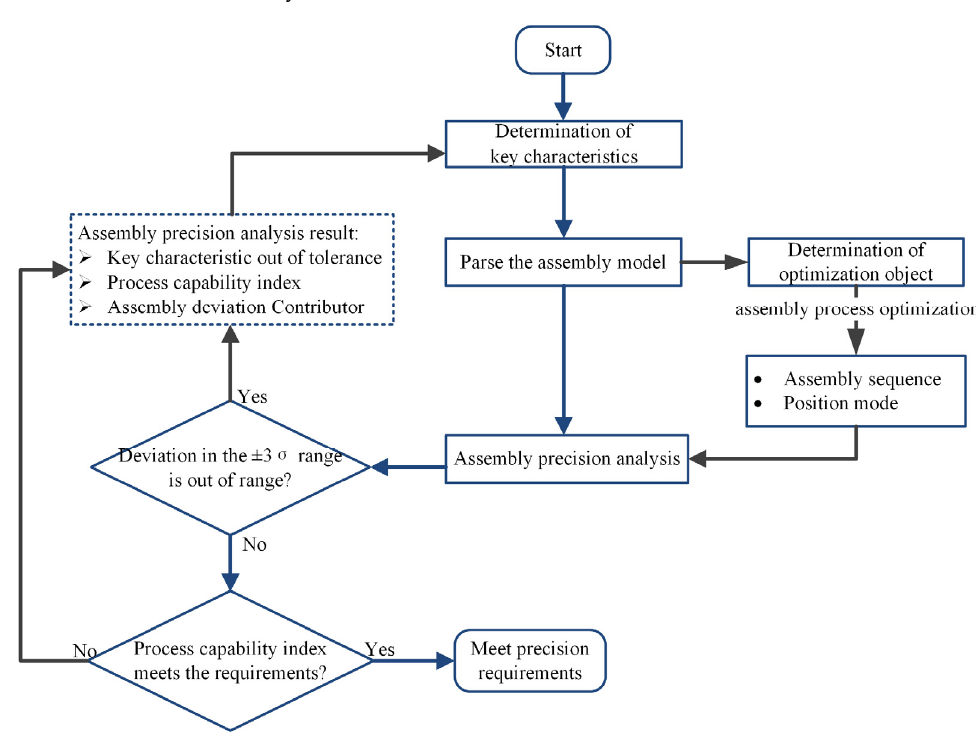
Figure 2. Assembly precision optimization